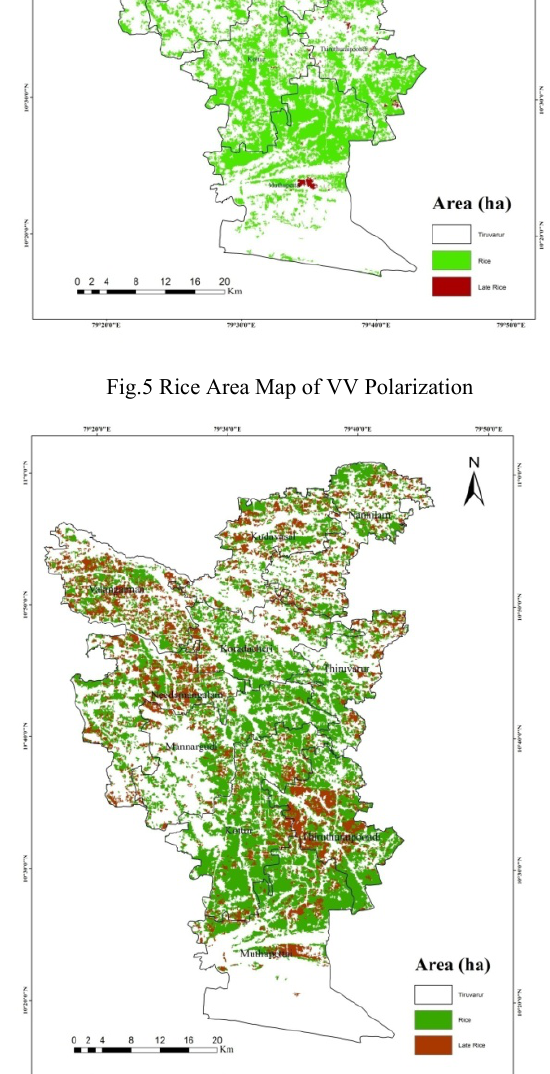
Fig.6 Rice Area Map of VH